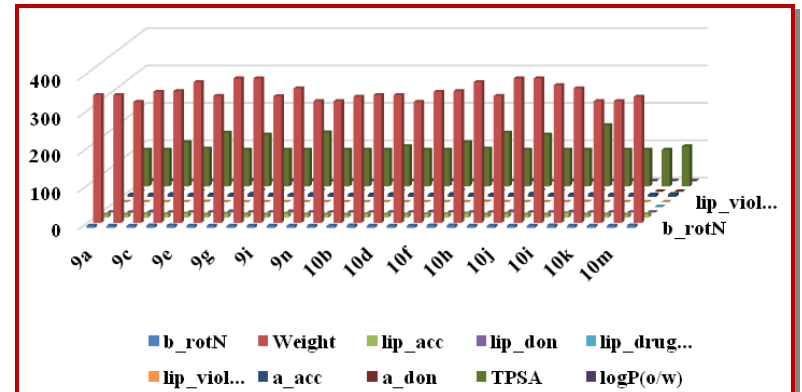
Figure 2: Drug likeness of the synthesized library of acetohydrazides